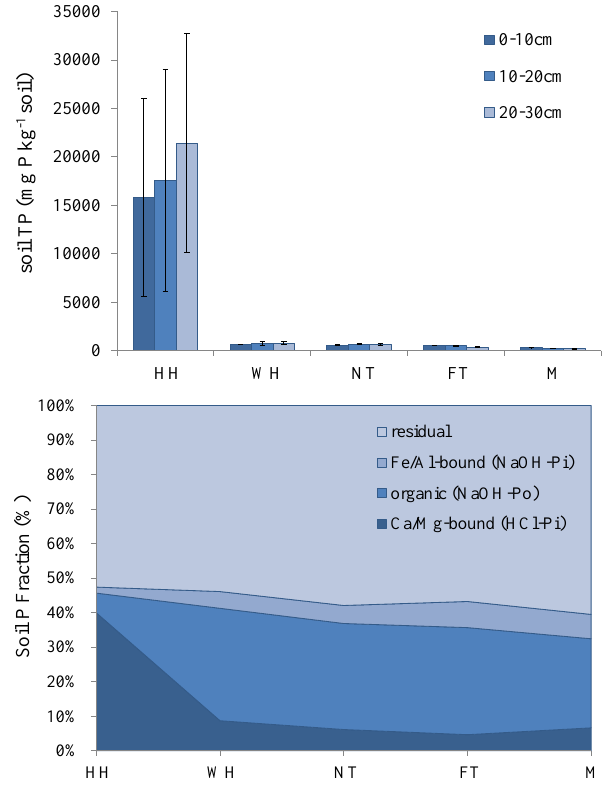
Fig. 2. (a) Soil total phosphorus concentrations in five plant com- munities High Head (HH), Wet Head (WH), Near Tail (NT), Far Tail (FT), and Marsh (M) and at three depths in tree island 3AS3. Error bars represent standard error. (b) Fractions of soil phospho- rus in the 0–10cm depth profile for five plant communities in tree island 3AS3.